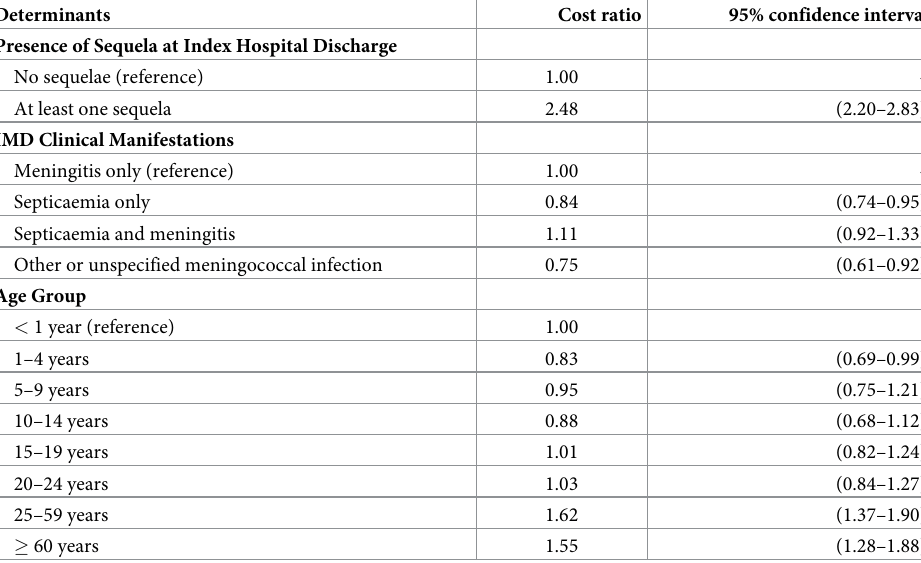
Table 4. Determinants of 1-year costs ( € 2018) among patients with at least 1-year follow-up (n =